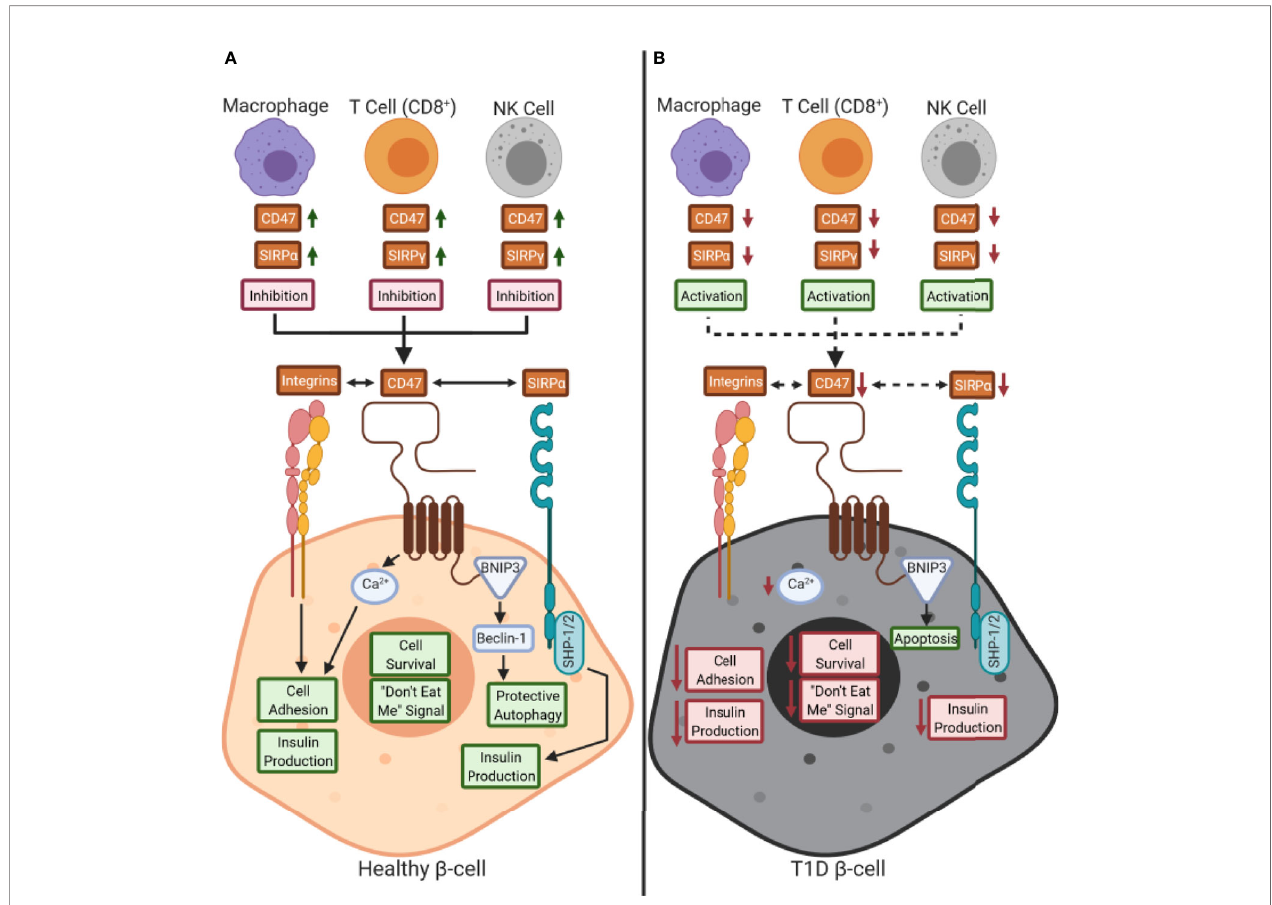
FIGURE 3 | Working model of the role of CD47:SIRPs signaling in health and during type 1 diabetes pathogenesis: (A) CD47 and signal regulatory protein (SIRP) are expressed by immune cells during a healthy state. CD47 controls calcium (Ca 2+ ) signaling in b -cells, through an unknown pathway, that promotes both cell adhesion and insulin production as well (29, 30, 34, 45). Also, CD47 is hypothesized to control protective autophagy via BCL2 interacting protein 3 (BNIP3) and Beclin-1 binding (34, 38). CD47 and SIRP a signaling can occur either in trans or in cis with each other or with other ligands, such as SIRP g . We hypothesize that a reduction of SIRP expression and/or activity occurs on immune cells in type 1 diabetes (T1D), thus inhibiting peripheral immune tolerance. (B) Decreased CD47 and SIRP a activity in b -cells could potentially inhibit insulin secretion and cell survival while increasing immune cell-mediated destruction. Red text box: inhibition; green text box: activation; dashed arrows: